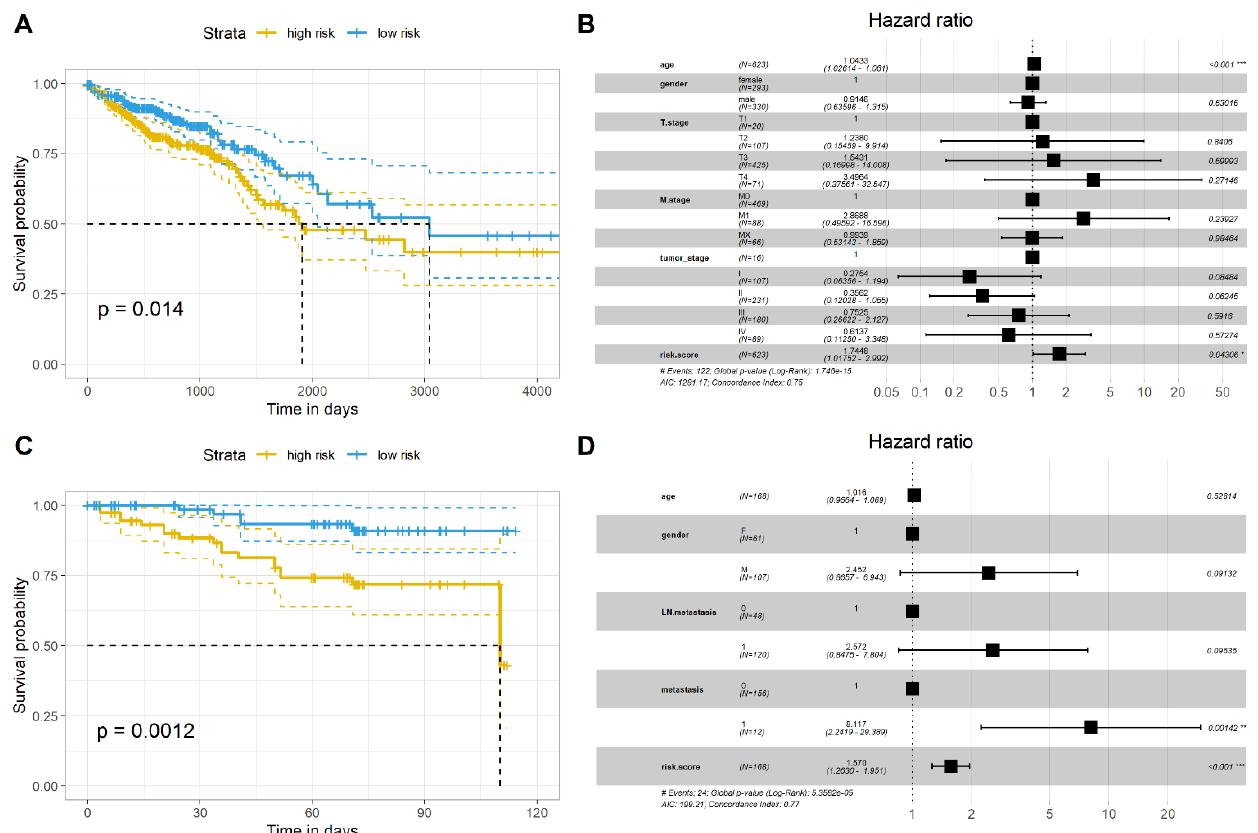
Figure 4. Validation of the gene signature in two independent datasets. ( A ) Kaplan–Meier plot revealed the survival time between high- and low-risk scores of gene signatures in the GSE87211 dataset; ( B ) the forest plot of clinical features and gene signatures in the prediction of the prognosis of CRC patients in the GSE87211 dataset; ( C ) Kaplan–Meier plot revealed the survival time between high- and low-risk scores of gene signatures in the TCGA-COADRAED dataset; ( D ) the forest plot of clinical features and gene signatures in the prediction of the prognosis of CRC patients in the TCGA-COADRAED dataset. * p < 0.05, ** p < 0.01,*** p < 0.001.